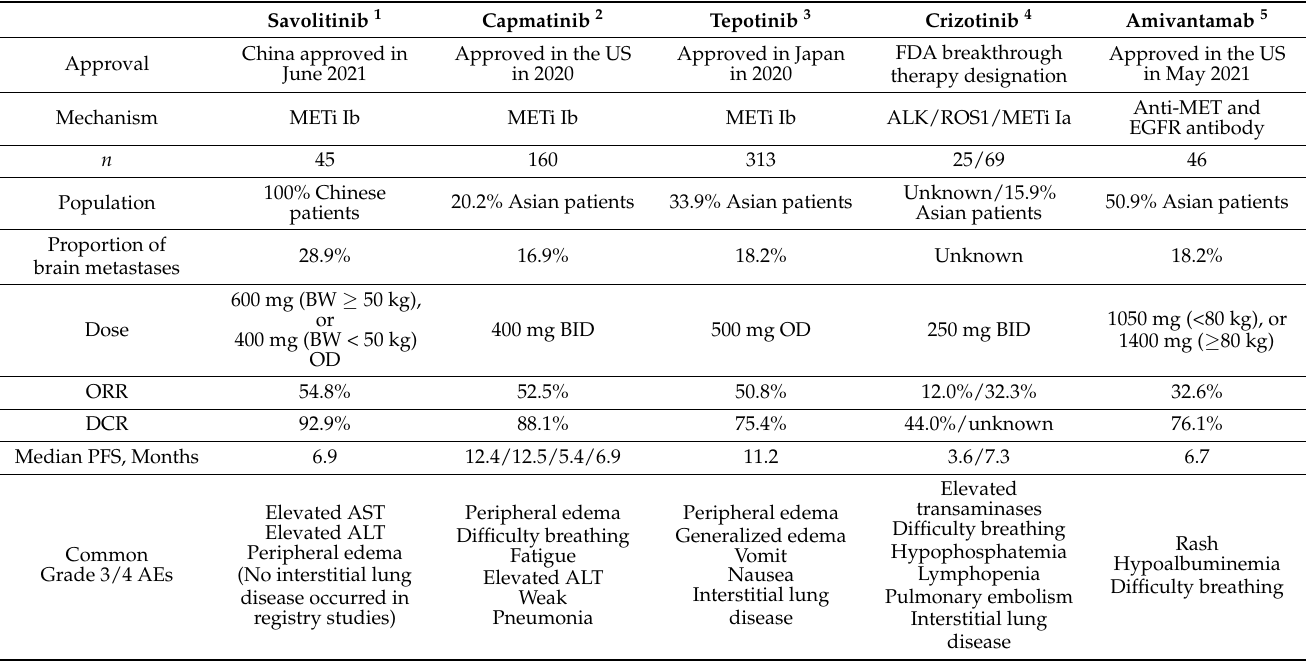
Table 5. Data summary of MET inhibitors in MET ex14